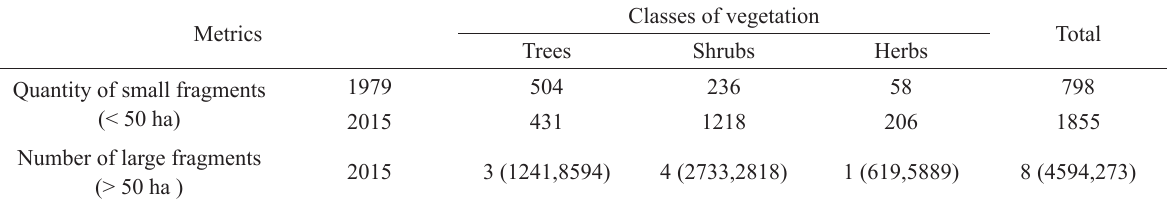
Vegetation classes and the metric “size of fragments”, for the fragmented area in the municipality of Conceição do Mato Dentro (Minas Gerais) for the years 1979 and